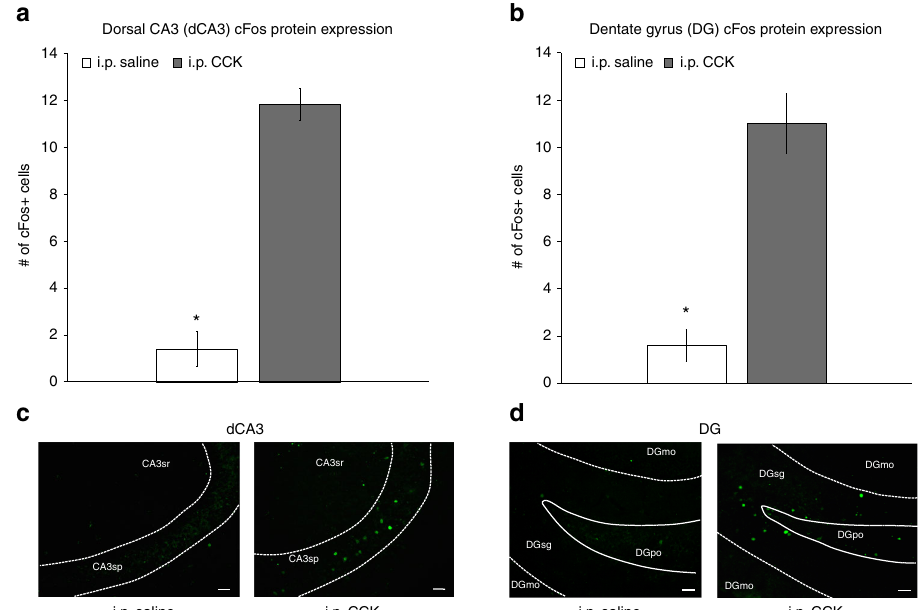
Fig. 4 Peripheral administration of CCK activates c-Fos protein expression in the dorsal CA3 (dCA3) and dentate gyrus (DG). Intraperitoneal injections of CCK ( n = 6) (a vagally mediated gastrointestinal-derived satiation signal) increases the number of c-Fos-immunoreactive (-ir) cells (a marker for neural activation) expressed in the a dCA3 and b DG vs. saline ( n = 5) treatment (ANOVA, F[1,9] = 20.236, p = 0.001492 (dCA3), F[1,9] = 37.917, p = 0.000167 (DG)). Representative images of immunohistochemical staining of c-Fos-ir protein (green) in the c dCA3 and d DG. Scale bar: 25 μ m. (* P < 0.05 vs. i.p. saline controls; data are mean ± SEM.; CCK cholesystokinin, i.p. intraperional, DG dentate gyrus, dCA3 dorsal CA3, CA3sr CA3 stratum radiatum, CA3sp CA3 pyramidal layer, DGmo dentate gyrus molecular layer, DGpo DG polymorph layer, DGsg DG granule cell